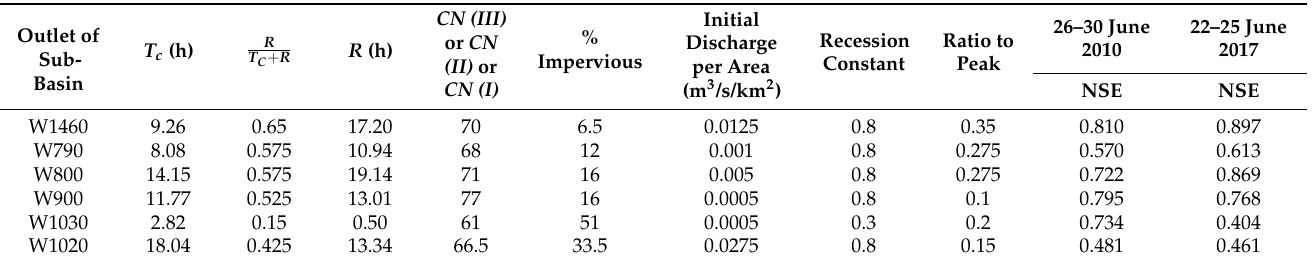
Table 14. HEC-HMS model verification via parameter calibration for the events of 26–30 June 2010 and 22–25 June 2017. Outlet of T c Sub- Basin